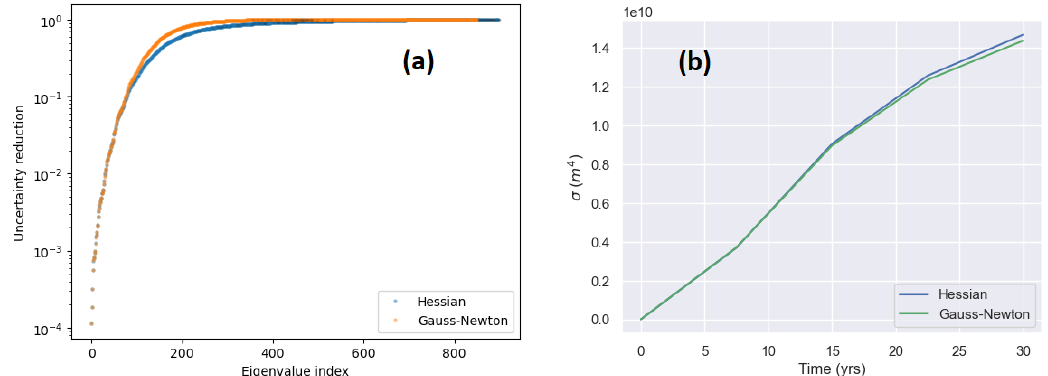
Figure 9. (a) Uncertainty reduction factor 1 /( 1 + λ k ) versus eigenvalue index k for γ = 10 and observational spacing of 2km, found with the full Hessian and Gauss–Newton approximation. (b) Hessian-based posterior uncertainties of Q IS Gauss–Newton